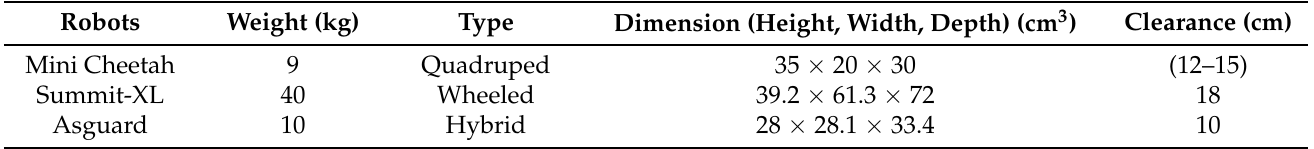
Table 2. Characteristics of the considered